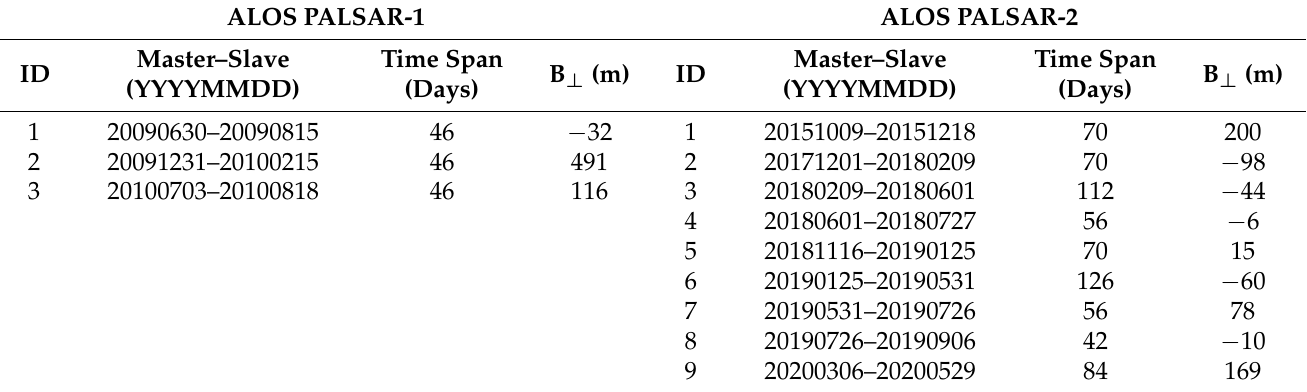
Table 2. The interferogram pairs from ALOS PALSAR-1/2 and their temporal and perpendicular spatial